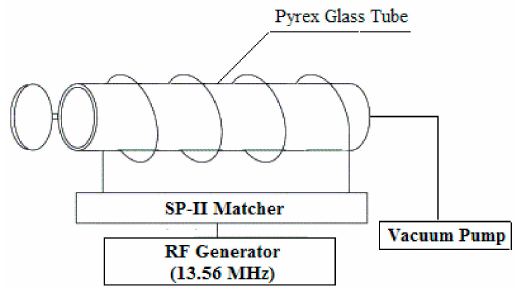
Figure 1. Schematic structure of plasma reactor for bio-decontamination from